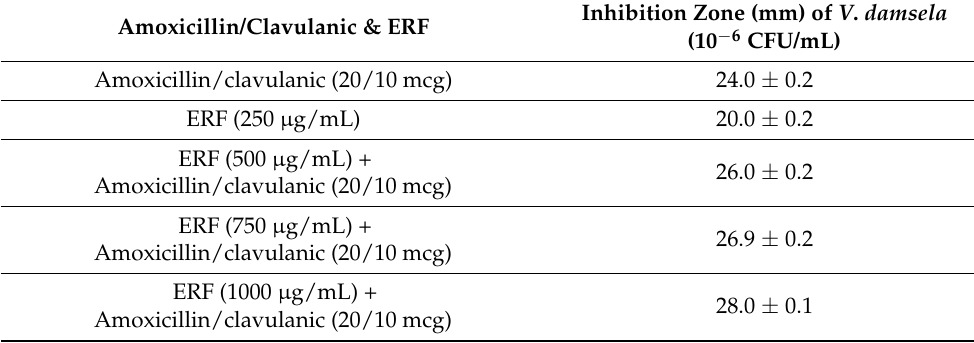
Figure 5. Synergistic effect of deferent concentrations of ERF and amoxicillin/clavulanic (20/10 mcg) acid against selected pathogen marine V. damsela. Table 8. Combined activity (Inhibition zone (mm)) of ERF with Amoxicillin/clavulanic against different V. damsela (10 − 6